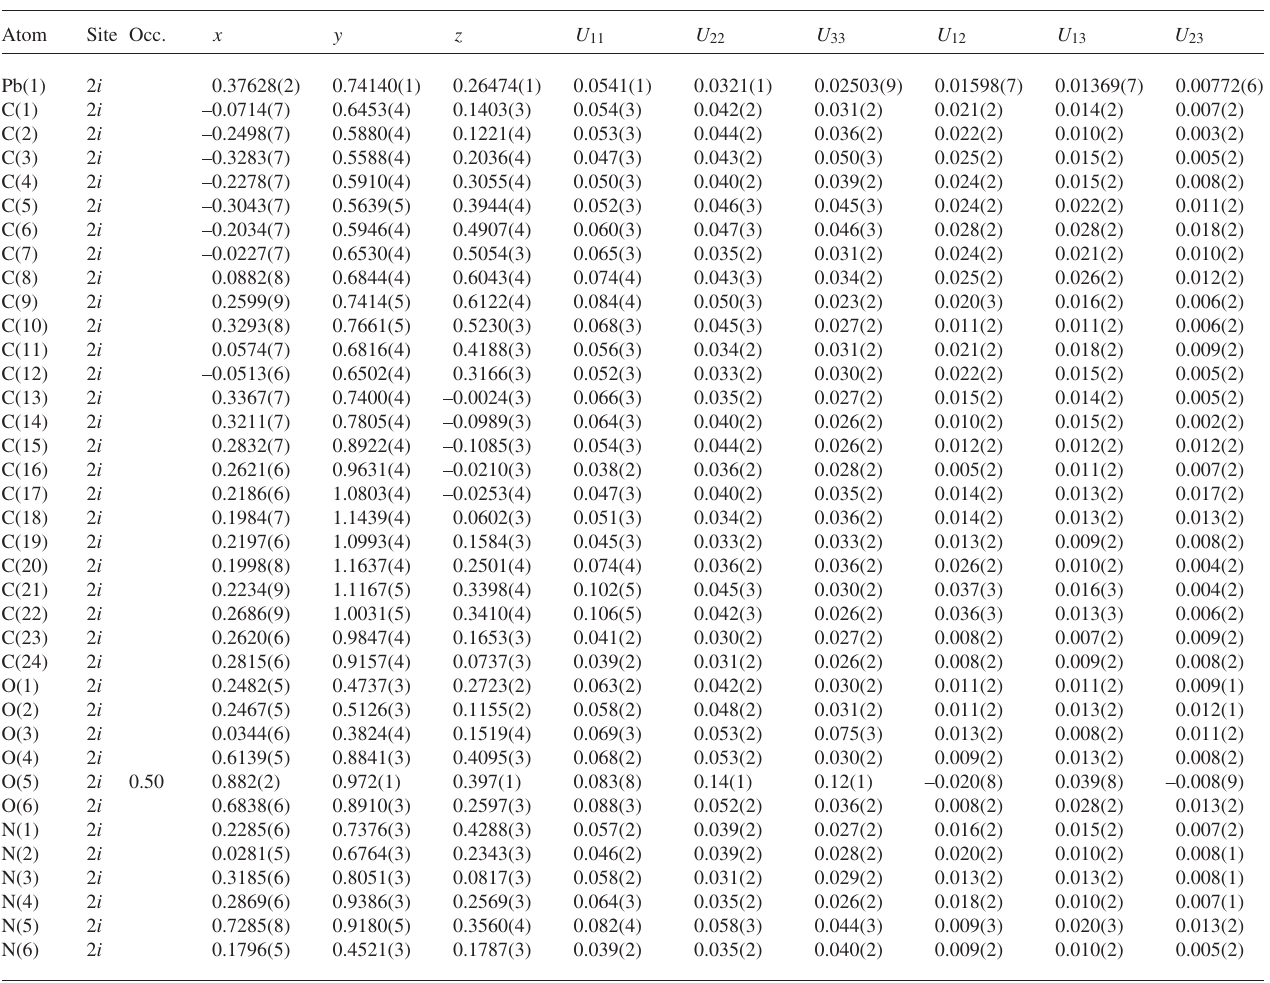
Table 3. Atomic coordinates and displacement parameters (in Å 2 ) .